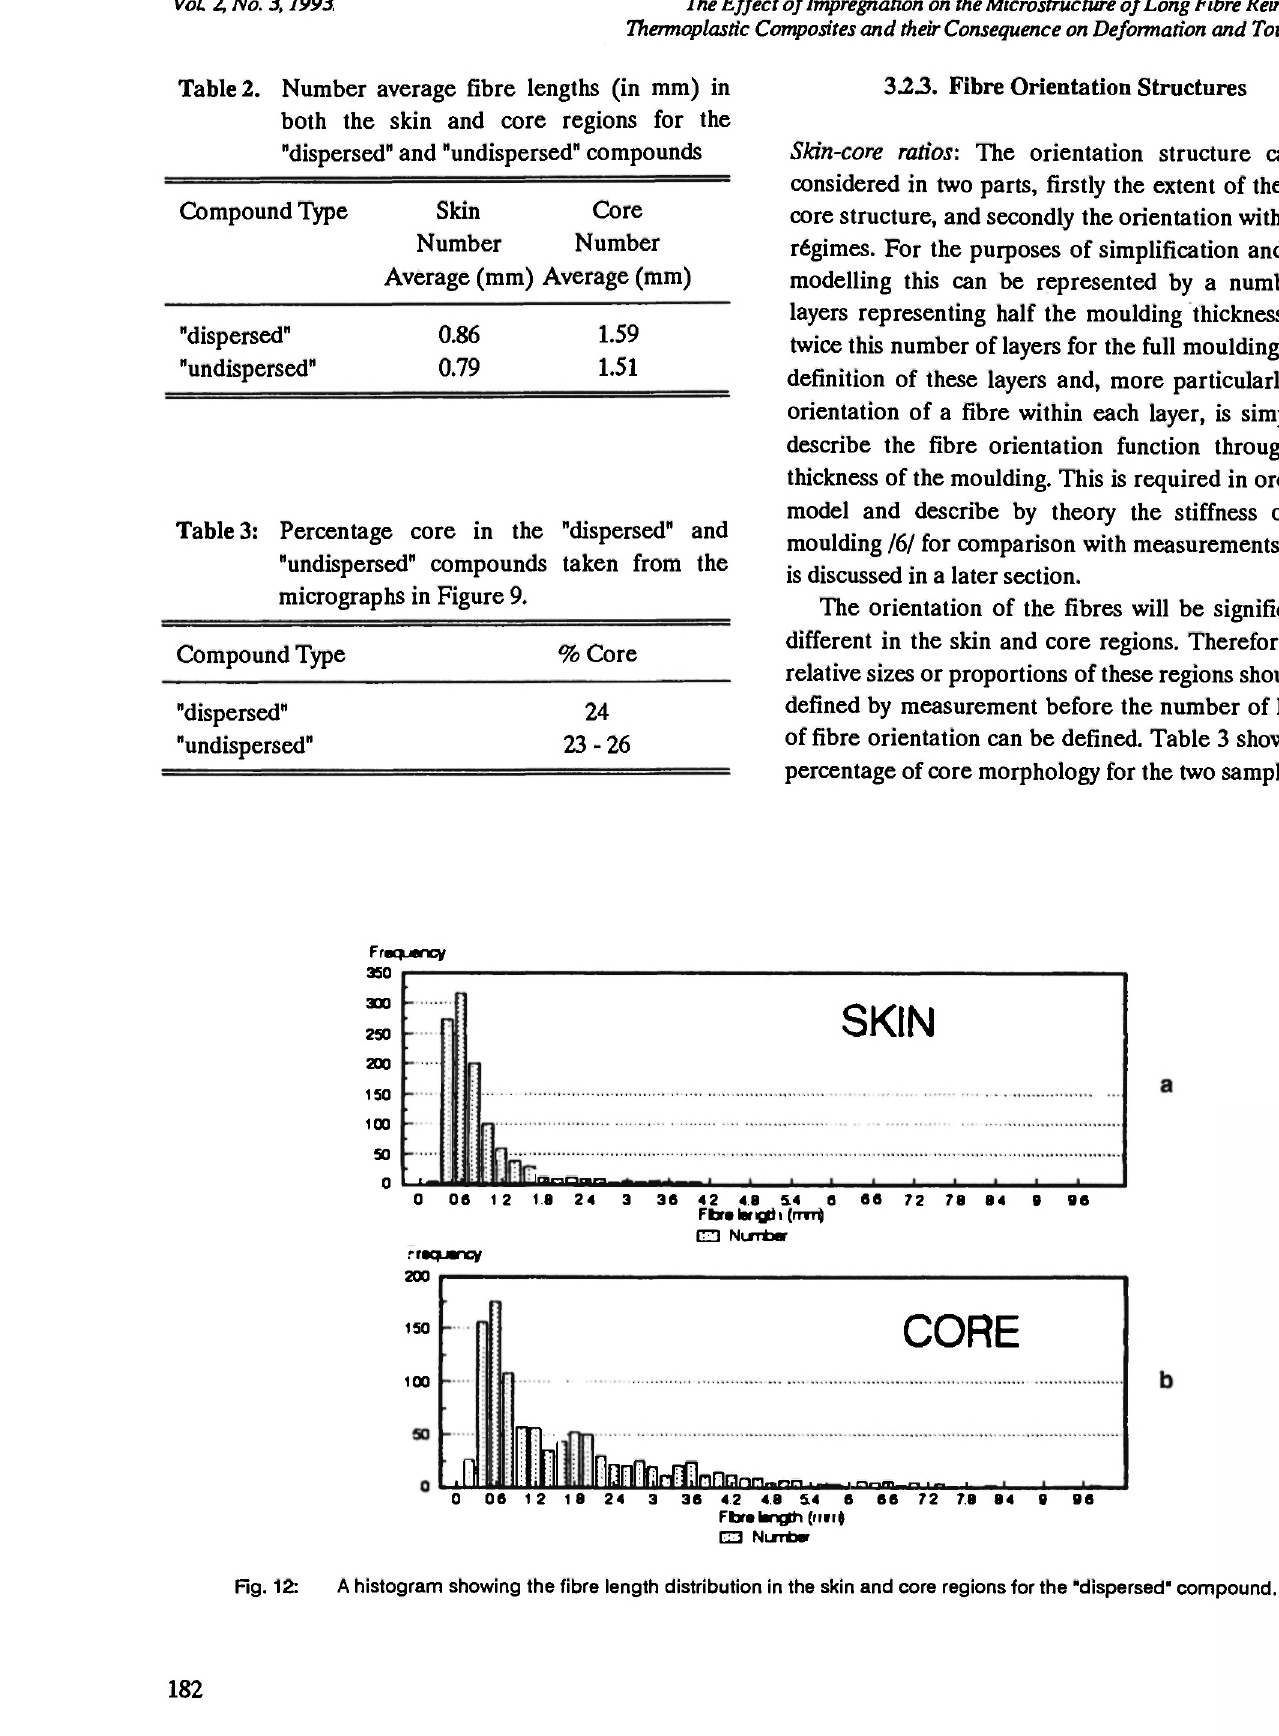
Table 2. Number average fibre lengths (in mm) in both the skin and core regions for the